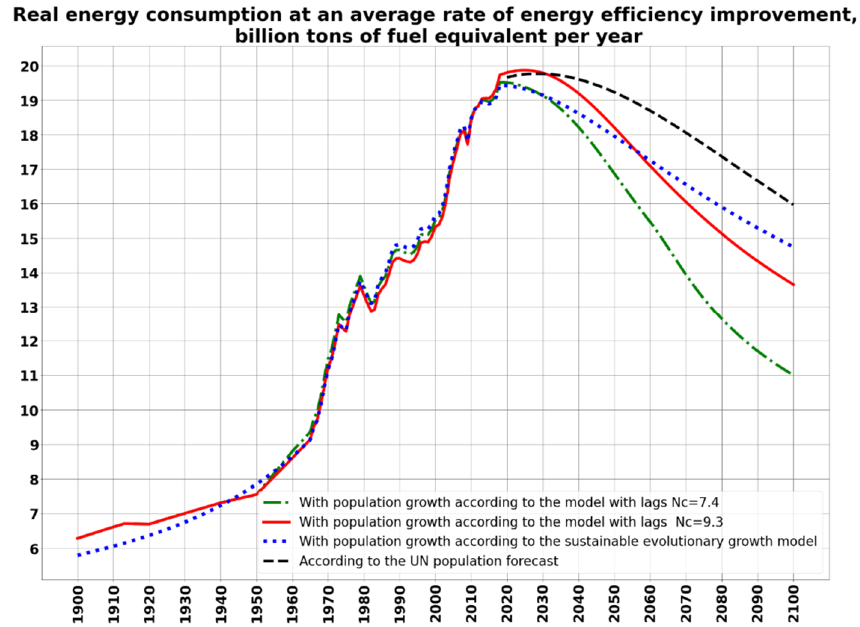
Figure 18. Dynamics of real global energy consumption in the 21st century.